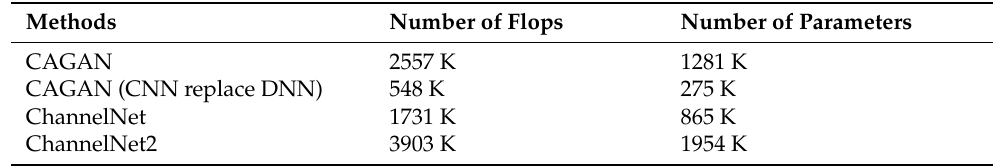
Table 1. The complexity analysis of different DL